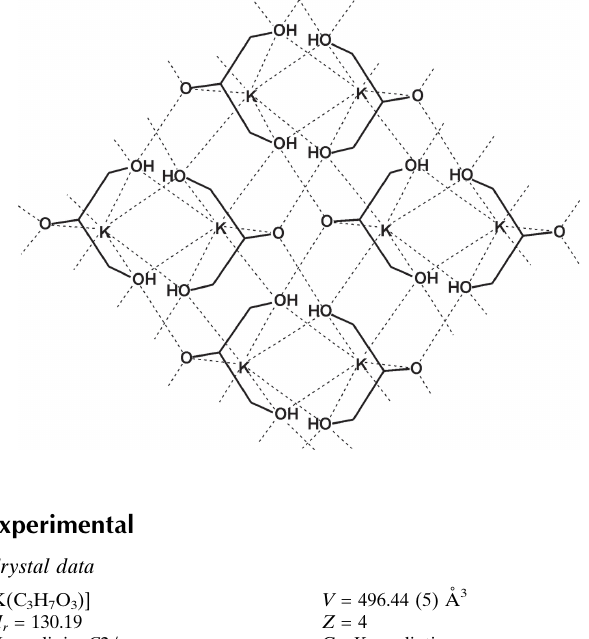
Data collection Bruker Proteum R SMART 6000 three-circle diffractometer